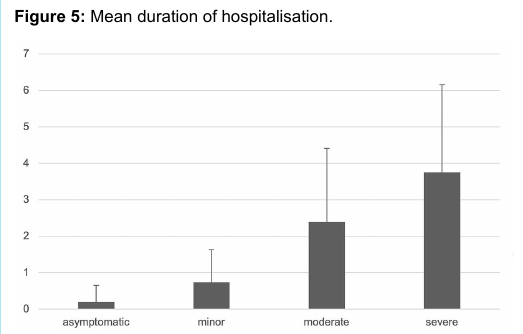
Figure 5: Mean duration of